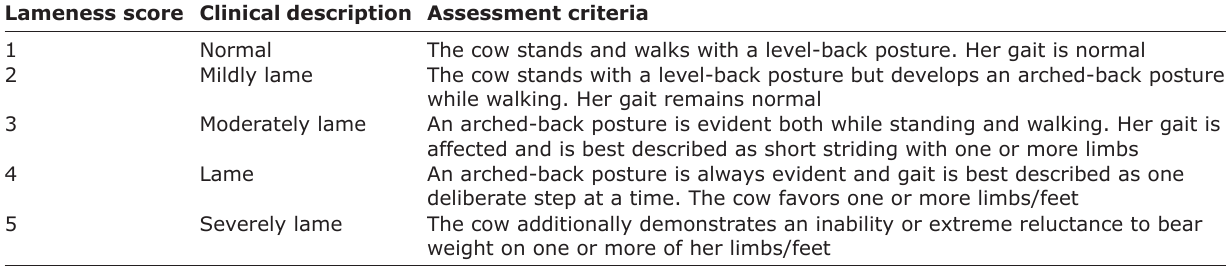
Table-1: Description of locomotion scoring system applied in our study based on criteria used to assign a lameness score and clinical description to dairy cows developed by Sprecher et al. (1997). Lameness score Clinical description Assessment criteria